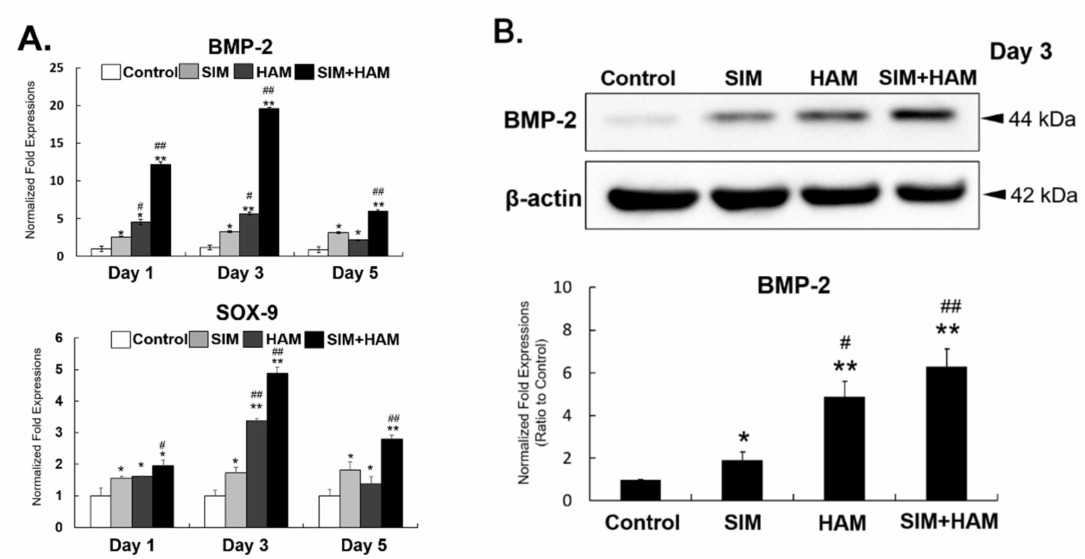
Figure 5. The optimal timing at which SIM plus HAM enhances BMP-2 expression in ADSCs is day 3. ADSCs were treated with SIM and cultured in wells with/without HA coating. BMP-2 and SOX-9 expressions in ADSCs were analyzed from days 1 to 5. ( A ) mRNA expression levels of BMP-2 and SOX-9 in the control, SIM, HAM and SIM+HAM groups from days 1 to 5. The gene expression levels are relative to those in the control group, which are defined as 1. ( B ) The protein expression levels of BMP-2 and β -actin in the control, SIM, HAM and SIM+HAM groups on day 3. The BMP-2/ β -actin expression ratio of each group is relative to that of the control group, which is defined as 1. The values presented are the means ± SEMs ( n = 4). (*) and (**) indicate p < 0.05 and p < 0.01, respectively, compared with the control group. (#) and (##) indicate p < 0.05 and p < 0.01, respectively, compared with the SIM